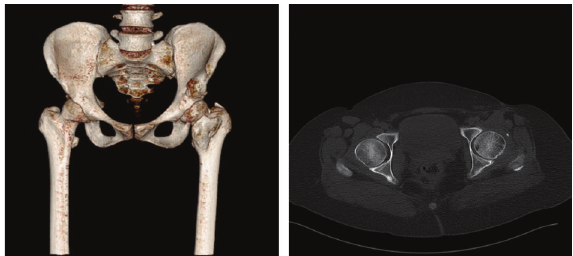
Figure 3: Post-op 2nd-year radiographic evaluation with 3D and axial view of CT.